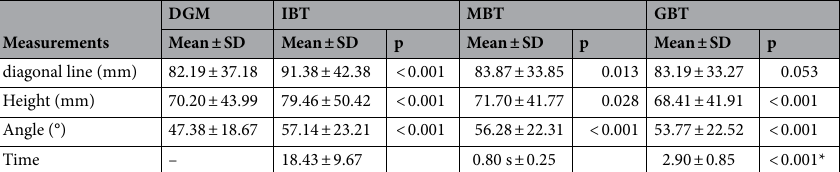
Table 2. Measurements and time requirements of graft reconstruction using DGM, IBT, MBT, and GBT. DGM designed graft model, IBT image-based technique, GBT guide-based technique. *There was a statistically significant difference between IBT and MBT, between IBT and GBT, and between MBT and GBT.